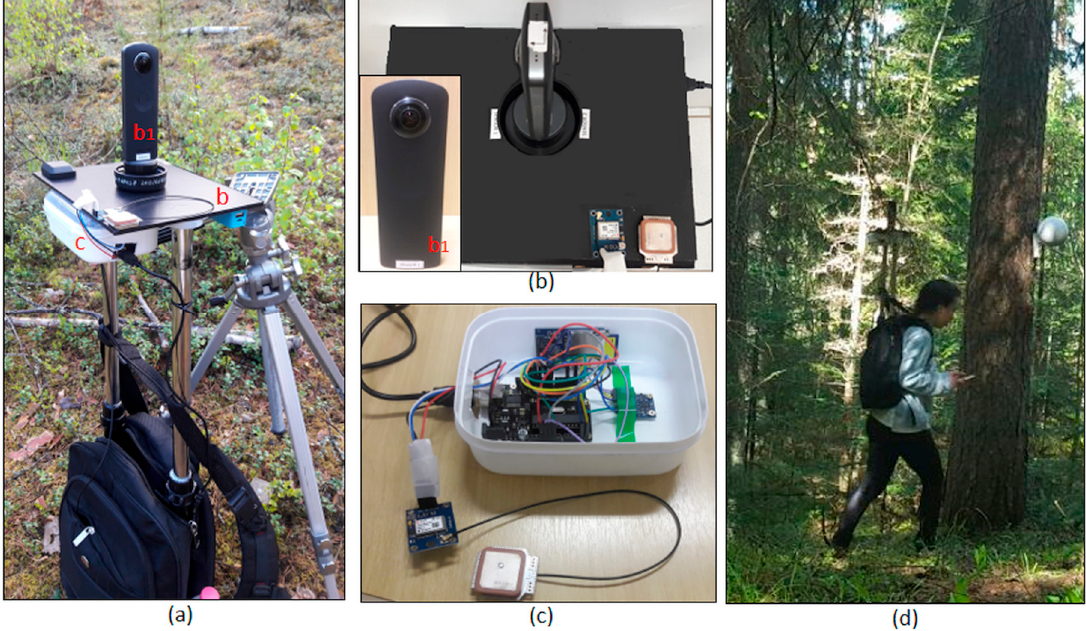
Figure 1. Personal Mobile Terrestrial System (PMTS): ( a ) backpack platform structure and PMTS sensors; ( b ) top view of platform with the omnidirectional camera and GPS receiver; ( c ) navigation sensors; and ( d ) example of an operator carrying the PMTS inside a forest.